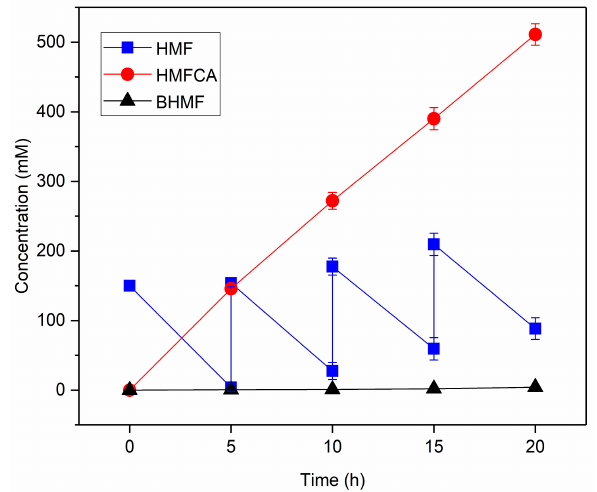
Figure 4. Synthesis of HMFCA by a fed-batch method. Reaction conditions: 150 mM HMF, 0.2 g/mL microbial cells, 5 mL phosphate buffer (100 mM, pH 7.0), 35 °C, and 850 rpm. In each cycle of 5 h, 0.75 mmoL of HMF was added.